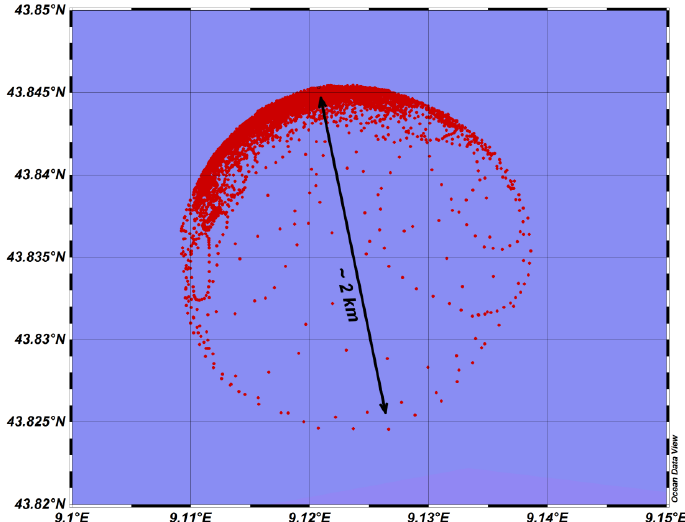
Figure 7. Positions of the buoy during the considered period, detected by GPS signal.